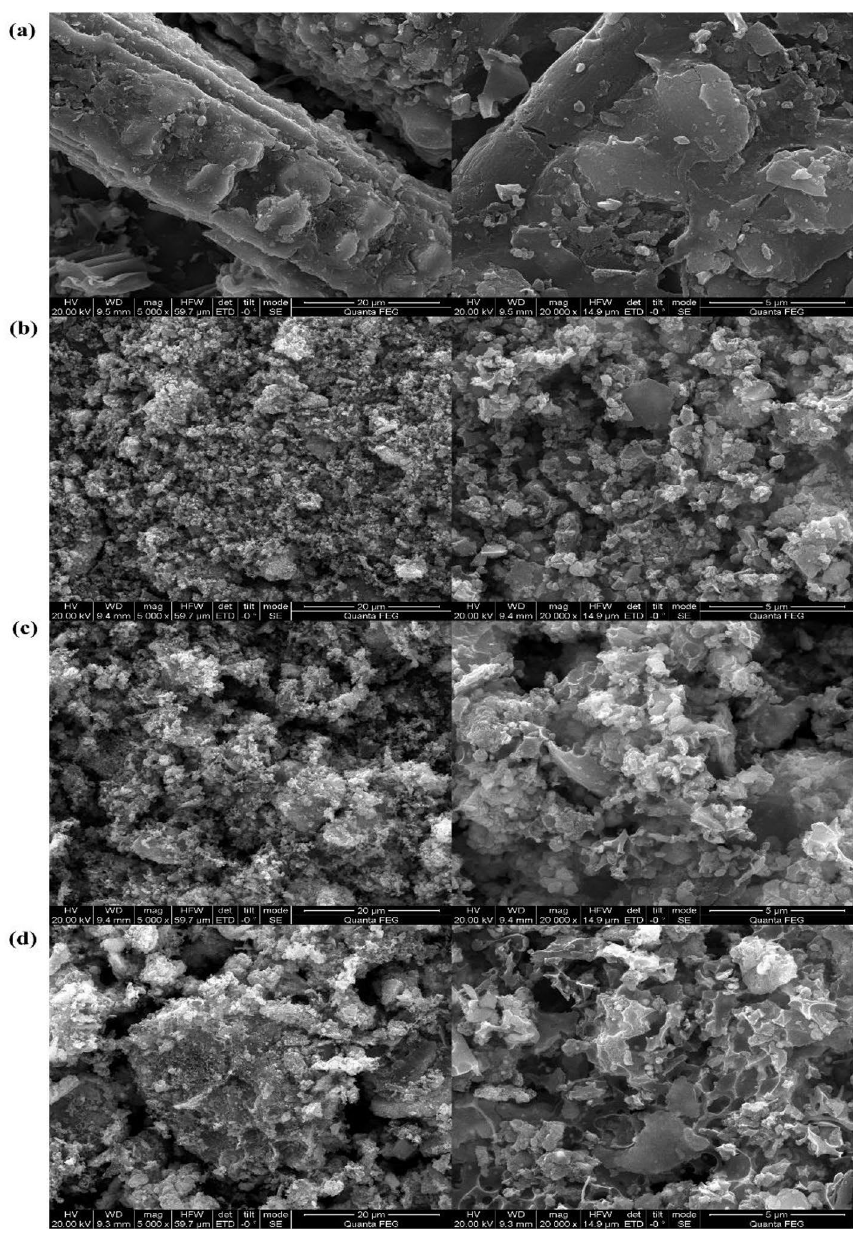
Figure 1. SEM images of ( a ) RBC, ( b ) KMBC, ( c ) 1% HAs/KMBC and ( d ) 10%